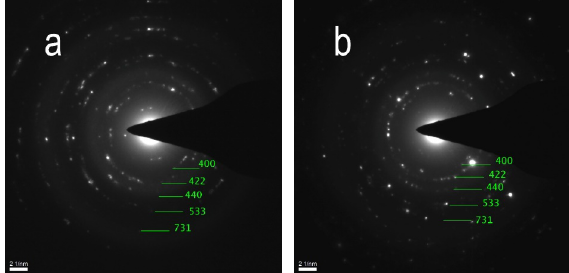
Fig. 3 Electron diffraction patterns of (a) MgGa 2 O 4 :Mn 2+ and (b) Eu-doped MgGa 2 O 4 :Mn 2+ ,Eu 3+ ceramics.